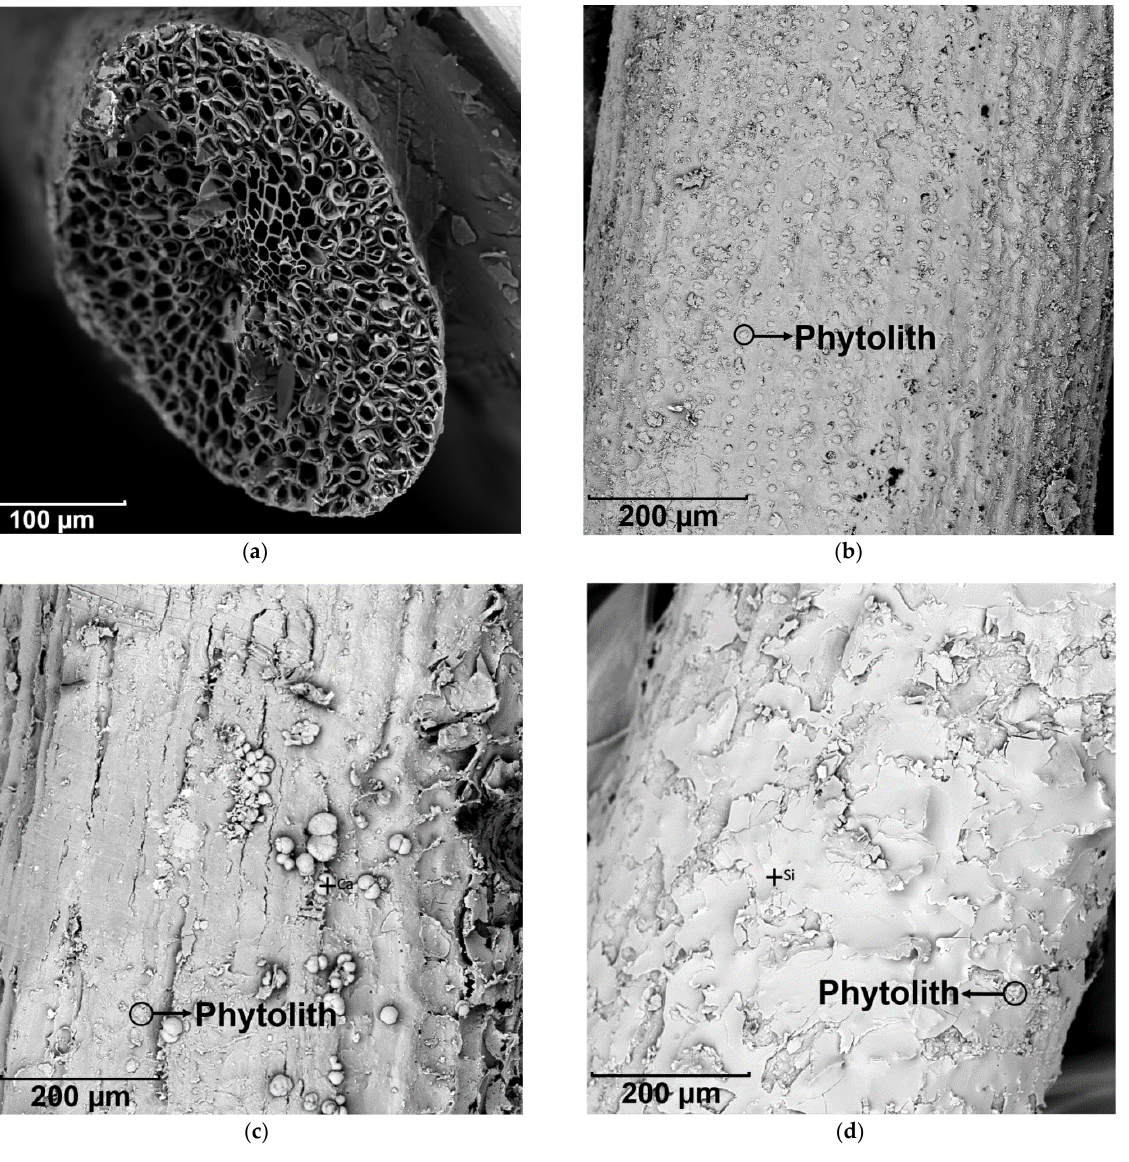
Figure 6. SEM pictures of coir fibers: ( a ) Cross-section of raw coir fibers, ( b ) surface morphology of raw coir fibers, ( c ) Ca(OH) 2 treated fibers, and ( d ) nano-silica treated fibers.